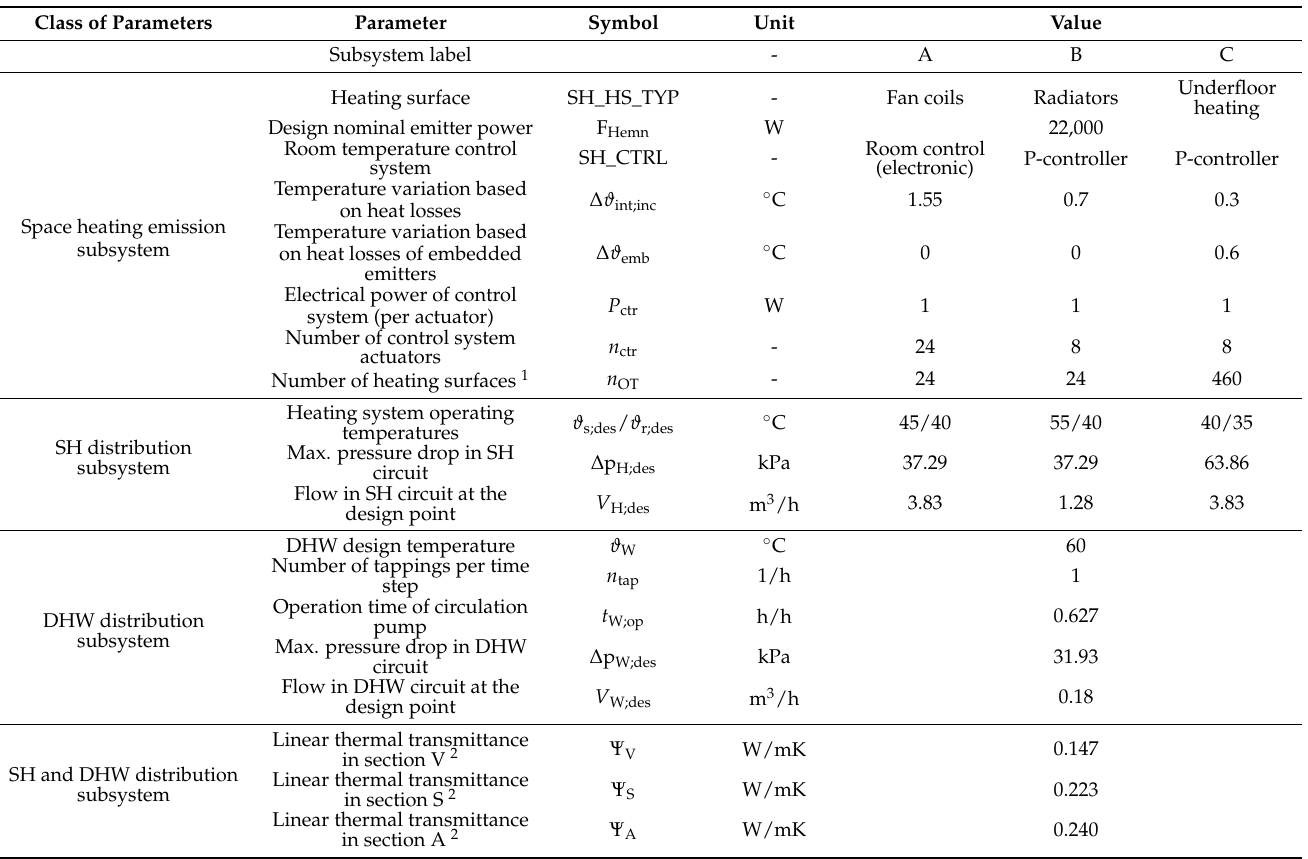
Table 4. Input data for the calculation of the space heating emission subsystem, SH distribution subsystem and DHW distribution